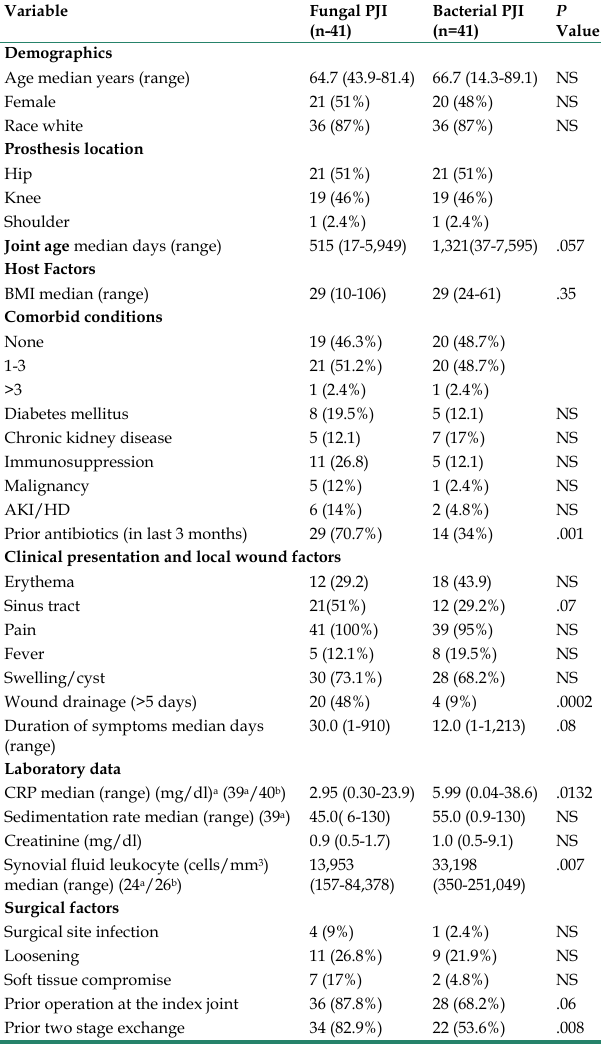
Table 1. Demographics and Clinical Characteristics of Cases and Controls Variable